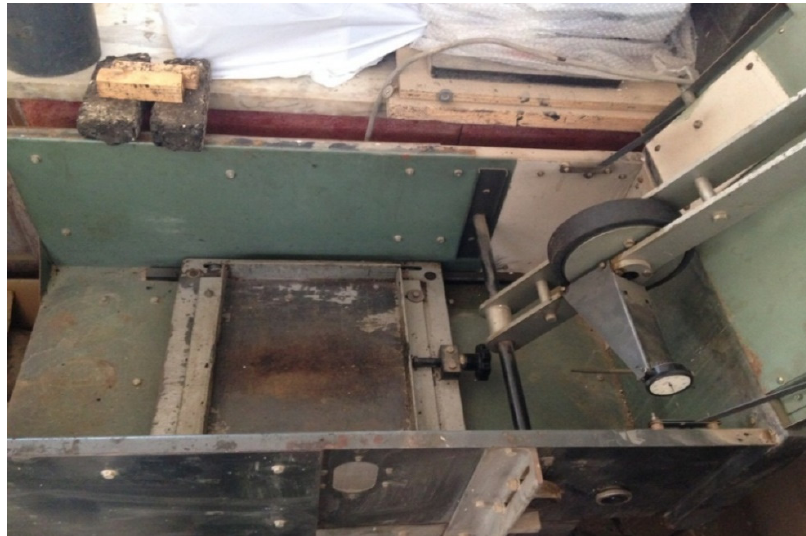
Figure 4. Wheel loading tracking device.